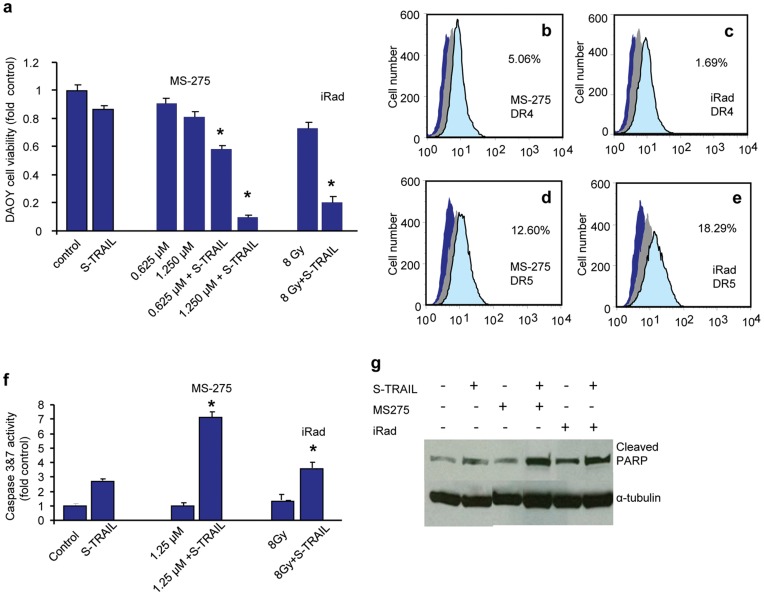
MS-275 and irradiation (iRad) treatment sensitize TRAIL resistant DAOY cells to S-TRAIL mediated apoptosis.(a) Plot showing the viability of DAOY cells treated with 0.5 µg/ml TRAIL for 24 hours, MS-275 (0.625 µM; 1.250 µM) for 48 hours, iRad (8Gy) for 72 hours and combinations with S-TRAIL. (b–e) FACS analysis of DR4 (b and c) and DR5 (d and e) DAOY cells treated with 8Gy iRad (light blue in b,c) and 1.25 µM MS-275 (light blue in d,e) (blue: isotype control, grey: untreated). (f) Caspase 3&7 analysis in DAOY cells treated with 0,5 µg/ml TRAIL (24 hours), 1.25 µM MS-275 (48 hours), 8Gy iRad (72 hours) and combinations of MS-275 and iRad with TRAIL. (g) Western blot analysis showing cleaved PARP and a-tubulin of DAOY cells treated with TRAIL, MS-275, iRad and combinations as described above. * denotes p<0.05 in the comparison of each treatment to controls, student’s t-test.